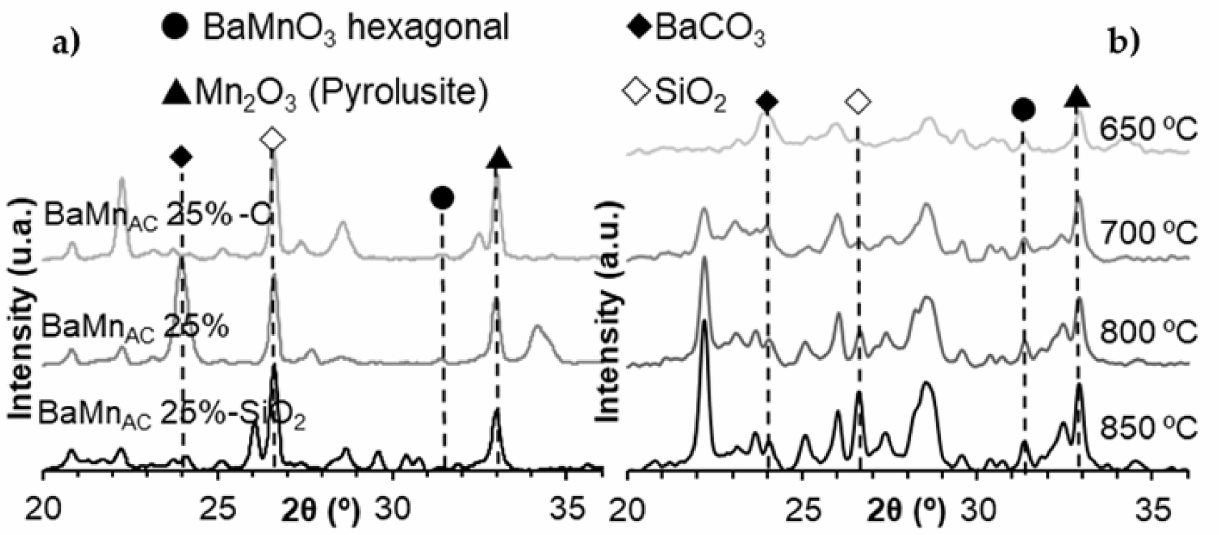
Figure A4. X-ray patterns of composites before (X-SiO 2 ), after silica removal (X) and after calcination (X-C) for the citric acid synthesis route: ( a ) 2:1 ratio SBA-15:BaMnO 3 , and ( b ) effect of the calcination temperature on b2 synthesis.